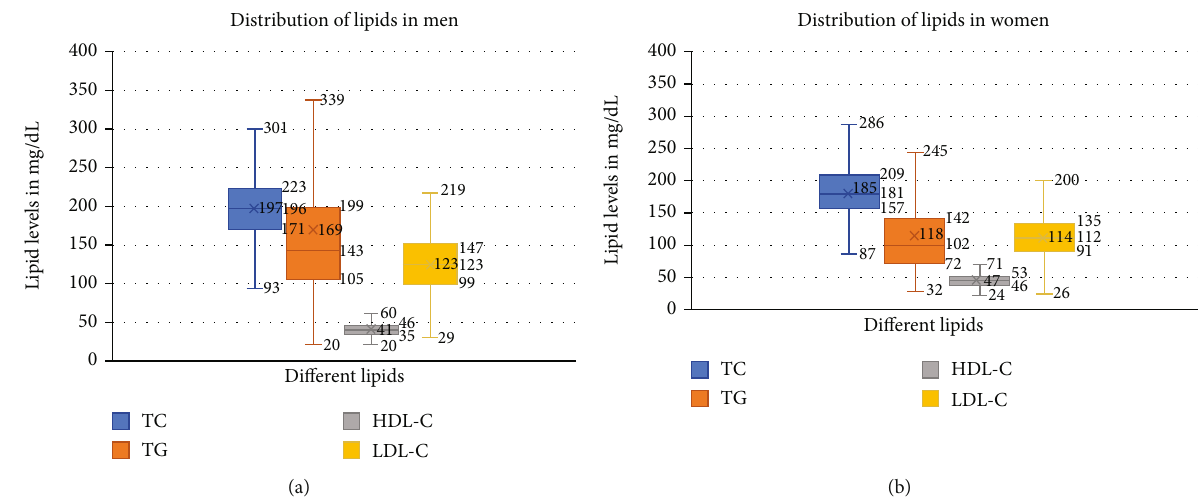
Figure 1: Distribution of lipids among men and women. (a, b) Distribution of lipids among men and women (box and whisker plot). The upper whiskers for TC, TG, and LDL-C are more in men than women, while high for HDL-C in women. TC has the highest level among all lipids in men with a median of 196 mg/dL, mean 197 mg/dL, and interquartile ratio (IQR) is 52 (223-171). The box of TG shows the median of 143 mg/dL, mean 168.9mg/dl, and IQR is 94 (199-105) in